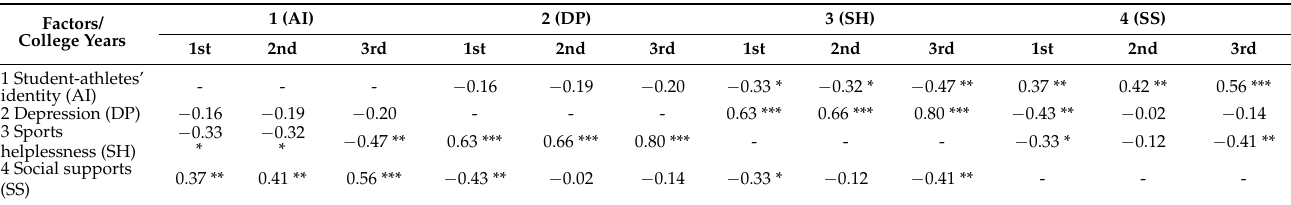
Table 4. Correlation coefficients between student-athletes’ identity, depression, sports helplessness, and social supports from